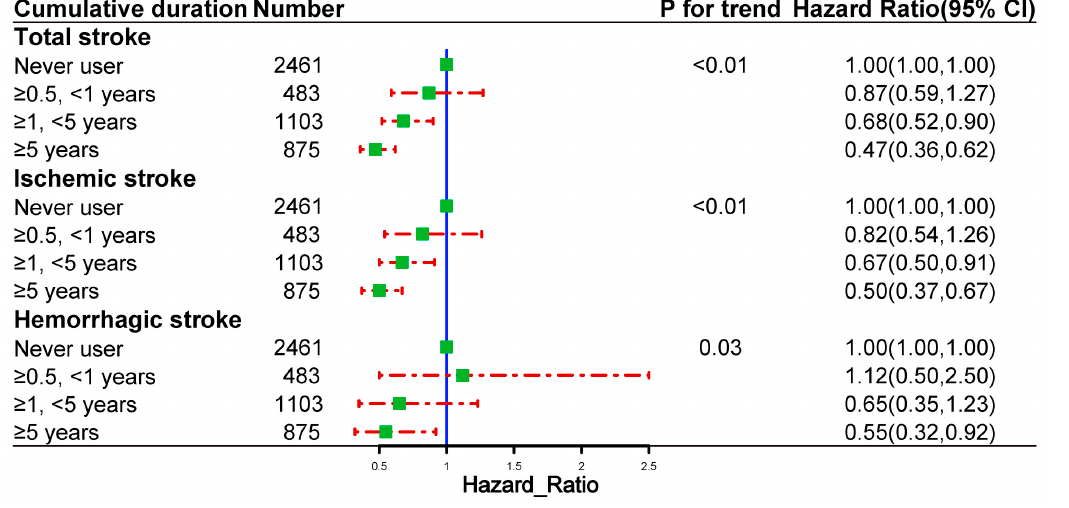
Figure 4. Dose–response relationships between the cumulative duration of spironolactone use and the risk of outcome events in propensity-score-matched cohort.